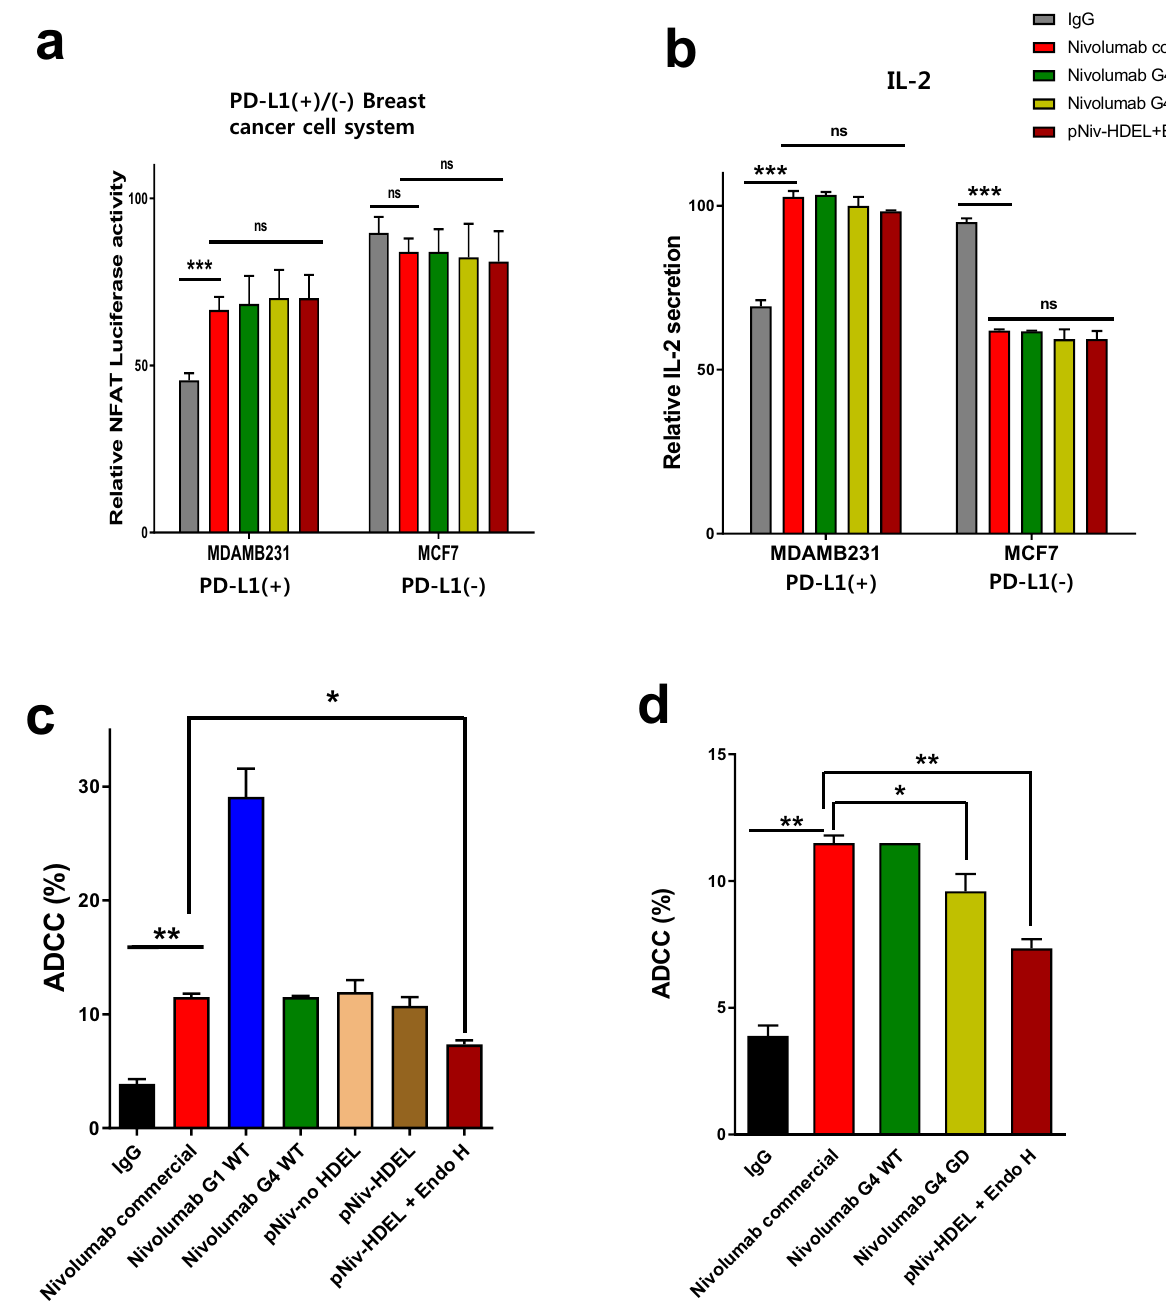
Figure 4. PD-1 blockade activity and ADCC efficacy of plant GD nivolumab. (a ) PD-1 blockade activity of plant GD nivolumab was confirmed by the NFAT luciferase assay. Jurkat PD-1-NFAT cells were co-cultured with PD-L1 (+) or PD-L1 (−) cancer cells and stimulated with the anti-CD3/anti-CD28 activator. Each antibody was treated at a concentration of 30 μg/mL, and luciferase activity was measured 6 h after stimulation. (b) IL-2 secretion activity of T cells. Jurkat PD-1 cells were co-cultured with breast cancer cell lines and treated with the anti-CD3/anti-CD28 activator and 30 μg/mL of antibodies. After 24 h, the supernatants were collected, and the amount of secreted cytokine was determined by ELISA with IgG as a negative control. (c) The ADCC efficacy of plant GD nivolumab was analyzed using calcein-loaded Jurkat PD-1 cells and FACS. Nivolumab G1 WT and IgG was used as positive and negative control, respectively. Cell death rate was deducted from the percentage of live rate which was calculated by the numbers of calcein-positive cells 6 h after 10 μg/mL of each antibody treatment. The effector cell: target cell ratio was 3:1. (d) Comparison of ADCC between plant GD nivolumab and CHO-GD nivolumab. Statistical significances were indicated as *p ≤ 0.05, **p ≤ 0.01, and ***p ≤ 0.001, respectively. ns, not